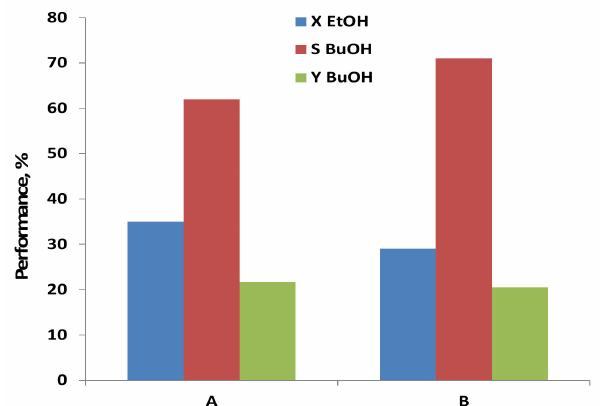
Figure 8. Effect of water in ethanol feed on the performance of C-HAP catalyst: A—anhydrous ethanol; B—hydrous ethanol; T = 400 ◦ C, WHSV = 0.8 h − 1 , time on stream (TOS) = 24 h. X—ethanol conversion; S—butanol selectivity and Y—butanol